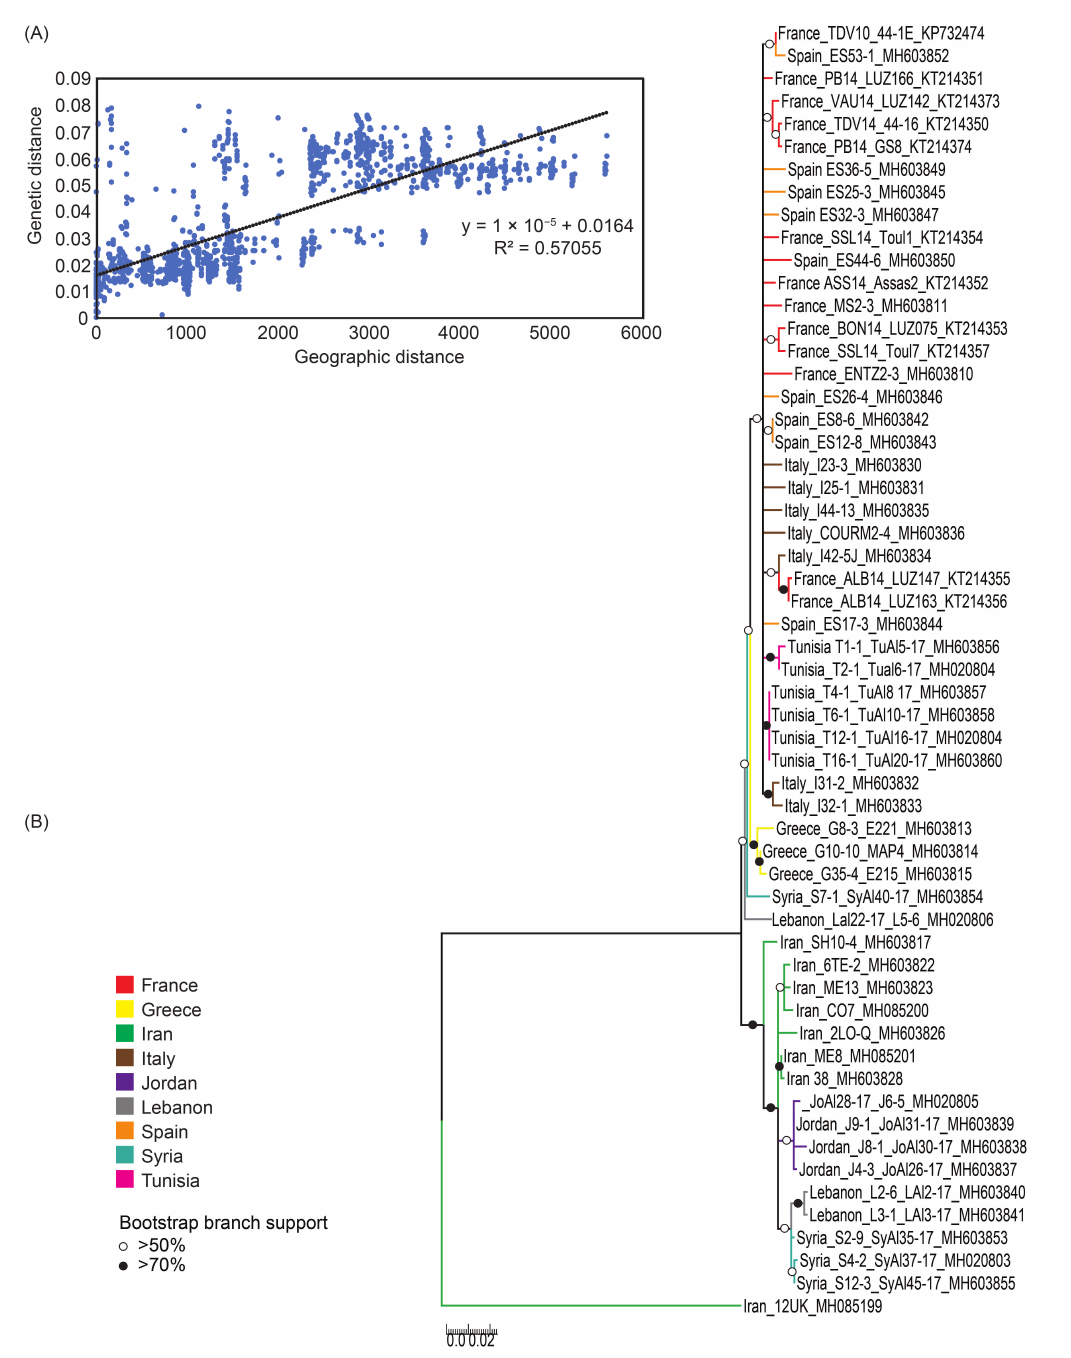
Figure 4. ( A ) Relationship of pairwise genetic distance of the 56 aligned ALCV-A full genome sequences with pairwise geographical distance (km). SSx (sum of products of x matrix elements) = 3.143 × 10 9 ; SSy (sum of products of y matrix elements) = 0.657; SPxy (sum of cross products of corresponding elements of the x and y matrices) 3.433 × 10 4 ; Rxy (Mantel correlation coefficient) = 0.755 and P (rxy-rand ≥ rxy-data); probability of Rxy based on 999 standard permutations across the full dataset = 0.001. ( B ) A maximum likelihood phylogenetic tree of the 56 aligned ALCV-A recombination-free genome sequences, with T92 + I + G selected as the best fit nucleotide substitution model and 1000 non-parametric bootstrap replicates. The tree was rooted with one Iranian isolate from ALCV-C (GenBank accession number: MH085199). Branches with less than 50% bootstrap support were collapsed. Branches associated with white and black dots have bootstrap support values above 50% and above 70%,